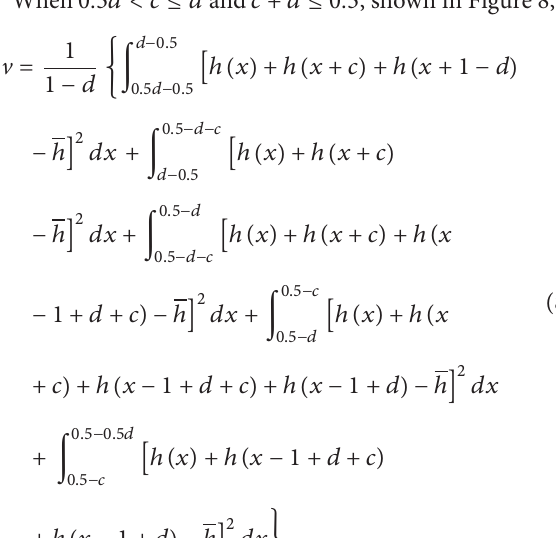
When 0.5𝑑 < 𝑐 ≤ 𝑑 and 𝑐 + 𝑑 ≤ 0.5 , shown in Figure